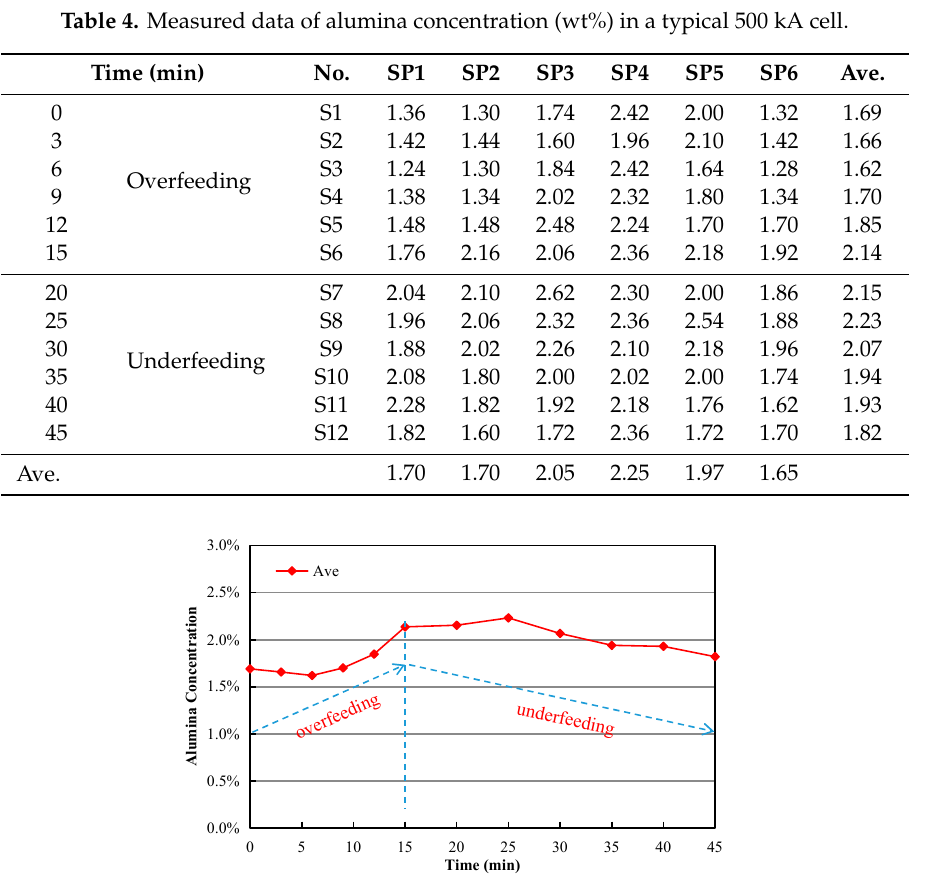
Figure 7. Average alumina concentration in a over and underfeeding cycle (measured data).